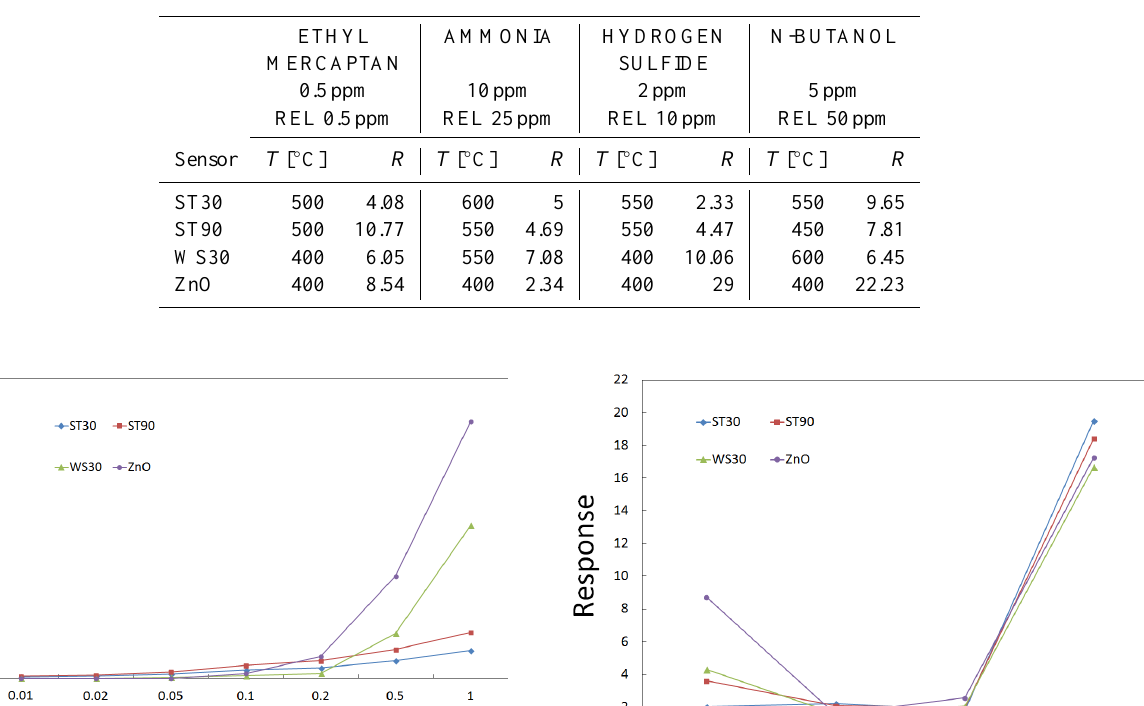
Table 1. The optimal working temperatures T best and the corresponding responses R for all analyzed films tested with gases of interest and reference gas n-butanol.